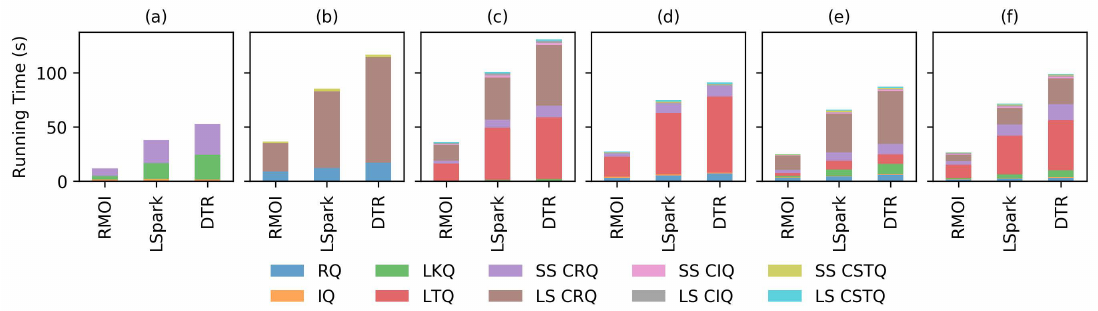
Figure 10. Stress testing for the RioBuses dataset with high resource availability on ( a ) 1st query set with 3 QTs, ( b ) 2nd query set with 3 QTs, ( c ) 3rd query set with 7 QTs, ( d ) 4th query set with 7 QTs, ( e ) 5th query set with 10 QTs, and (f) 6th query set with 10